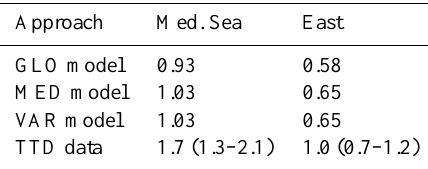
Table 5. Total δC T inventory (PgC) for the entire Mediterranean Sea and for the eastern basin as simulated and as estimated by the TTD data-based method (Schneider et al.,